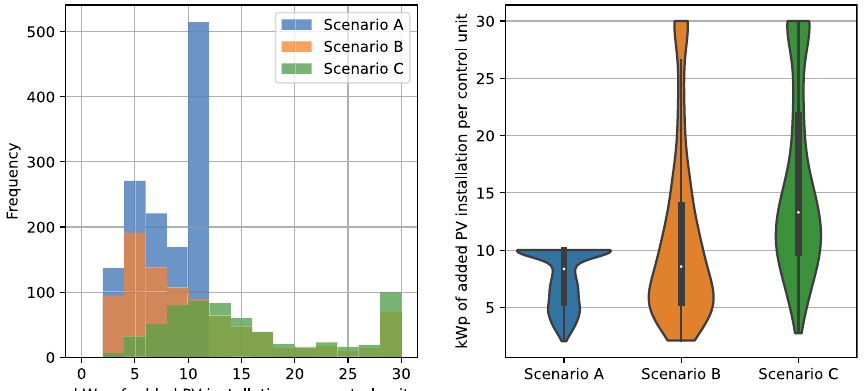
Fig. 9 Visualization of the distribution of simulatively added PV installations grouped by the defined scenarios. Left: The distributions visualized in a histogram. Right: Violin plots of the distributions. Scenario D is not evaluated in this context and Scenario E has a fixed PV power of 10 kWp